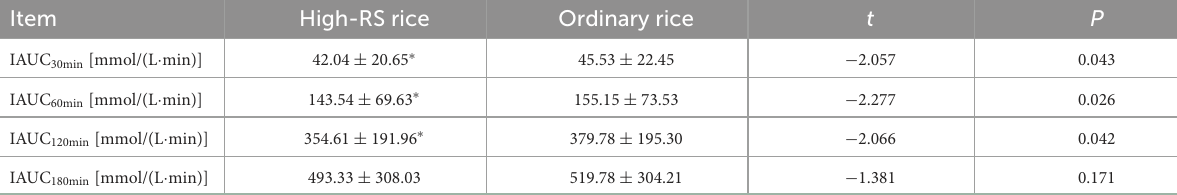
TABLE 4 Comparison of IAUC (mean ± SD) between high-RS rice meal and ordinary rice meal ( n = 73).